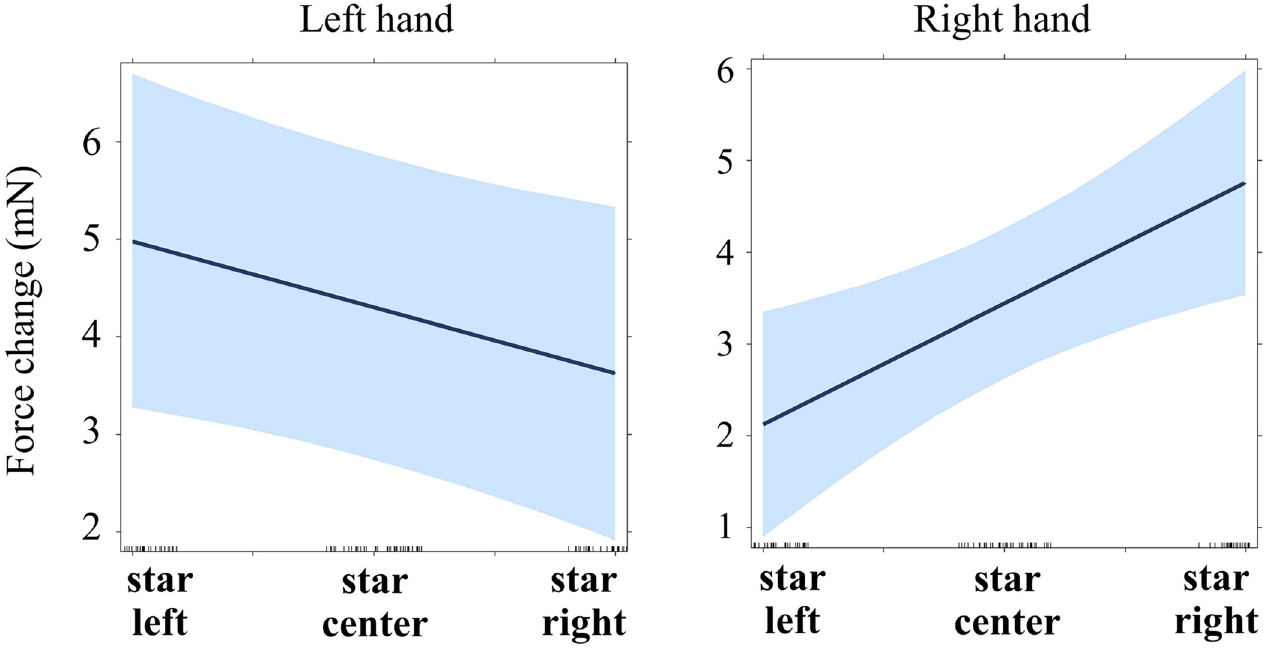
Fig 4. Regression lines for the main effect of star position on force (Experiment 1, time window 60–130 ms). See main text for details (Models 1.3 and 1.4).